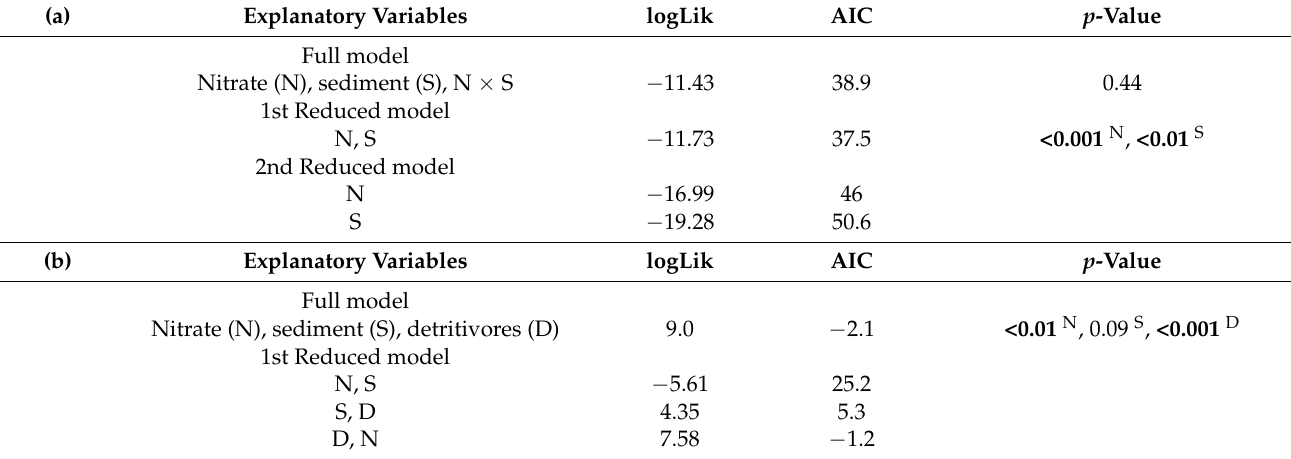
Table 3. Results of GLMMs testing the effects of nitrate, sediment, and their interactions on residual k ( a ), and the effects of nitrate, sediment, and log 10 -transformed standardized abundance of detritivores on residual k ( b ). The effects of log 10 -transformed standardized abundance of detritivores on log 10 -transformed leaf litter decomposition rate (b). Full models and reduced models were each compared using log-likelihood tests; when full models were insignificant, 1st reduced models were compared to 2nd reduced models sequentially. Superscripts of p -values indicate the variables removed from the model to test with those from reduced models by one level. Bold letters for p -value denote statistical